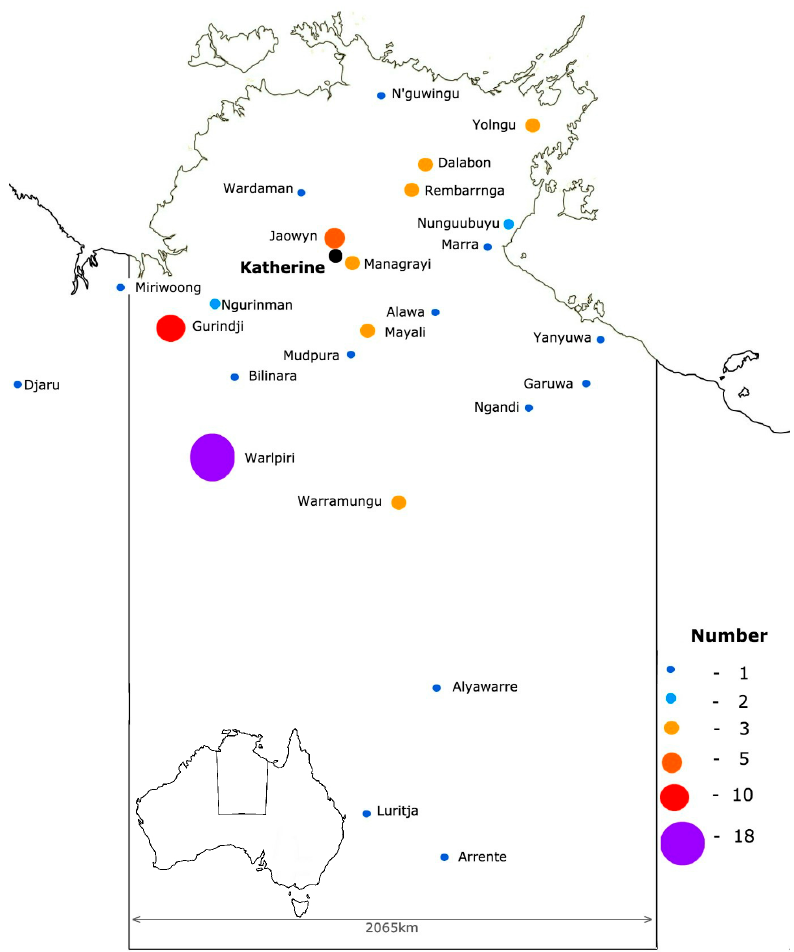
Figure 2. Geographic distribution of the tribal groups * of participants (* Sixty-eight participants identified as tribal origin within the NT, six participants were outside NT, 25 participants identified as Aboriginal with origin not defined, and 10 participants identified as non-Aboriginal).